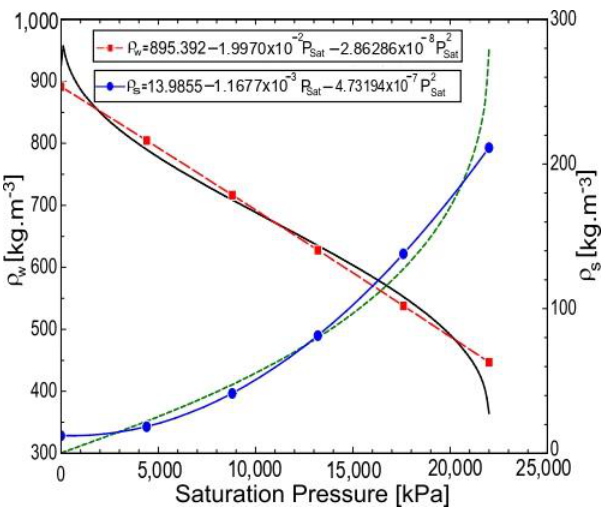
Figure 6. Graph used to determine the density polynomials of saturated liquid and saturated steam through linear regression (curve fitting) in the EES ® software.